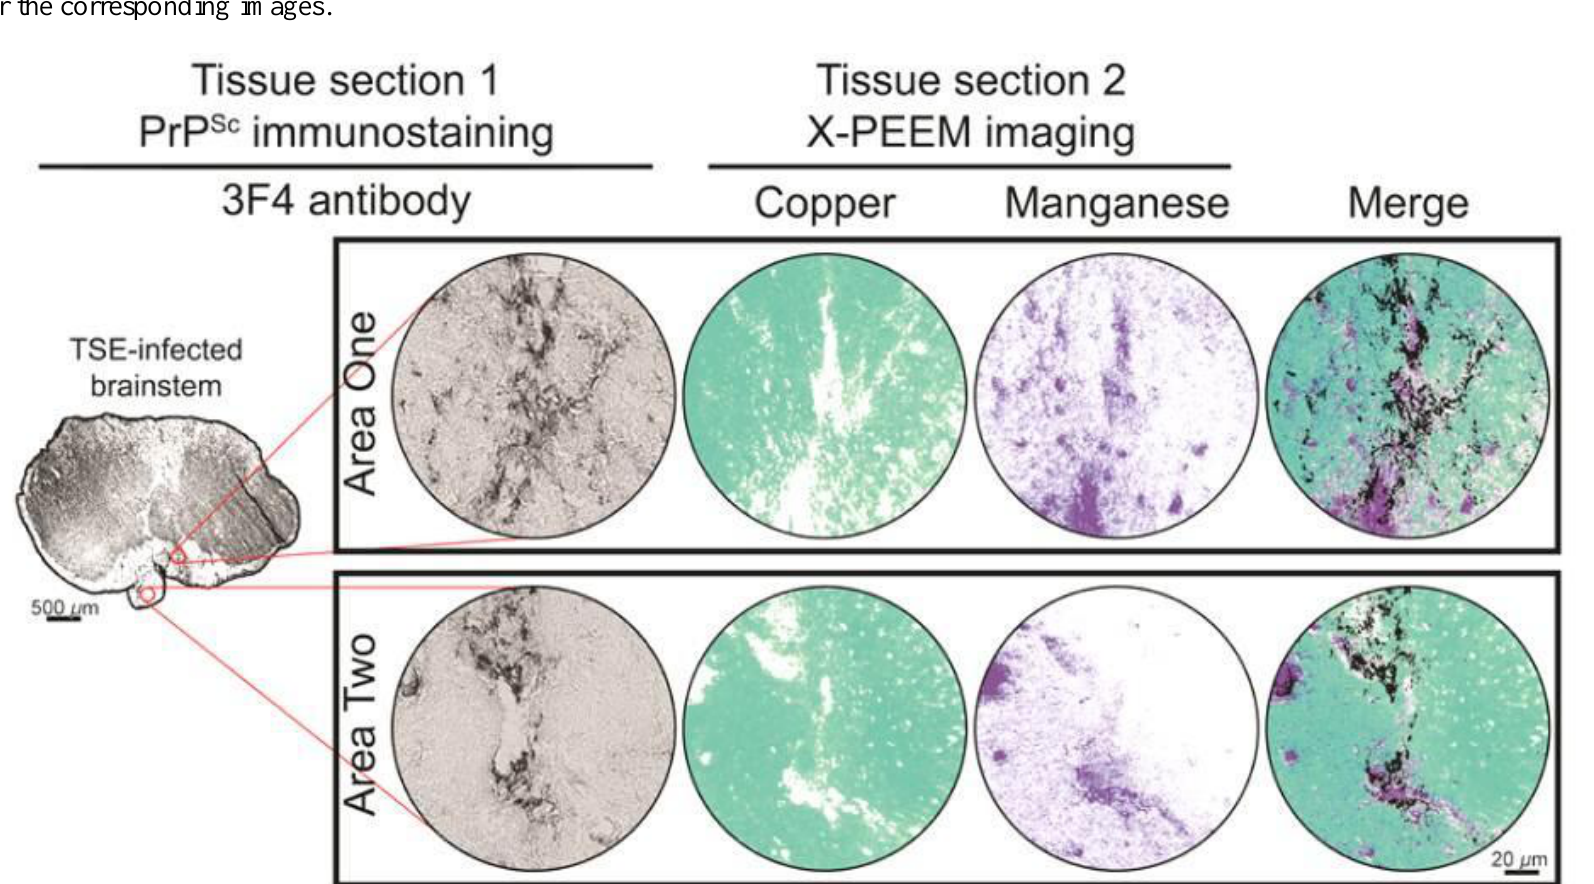
Figure 1. A coronal section (Tissue section 1) of a brainstem from a HY TSE-infected hamster was immunostained for PrP Sc with